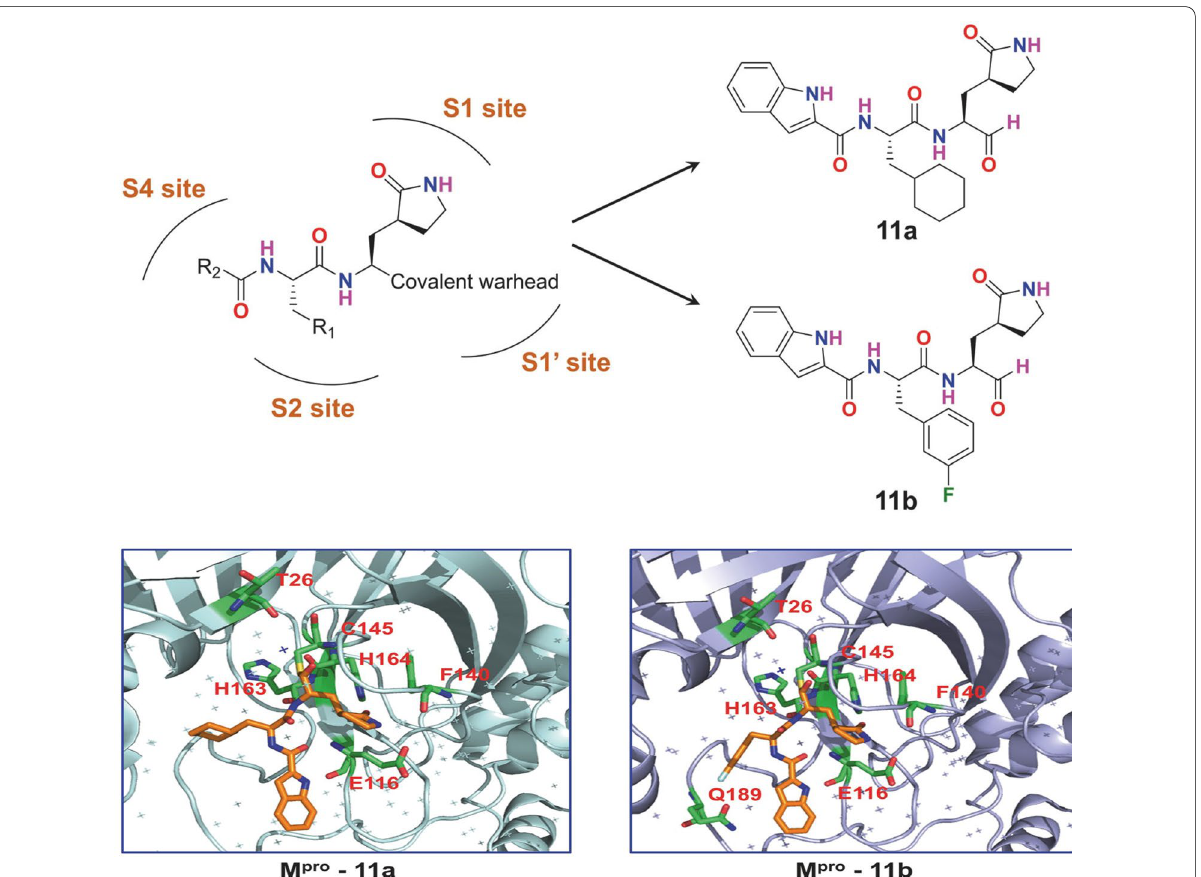
Fig. 1 Discovery of drug targeting M pro against